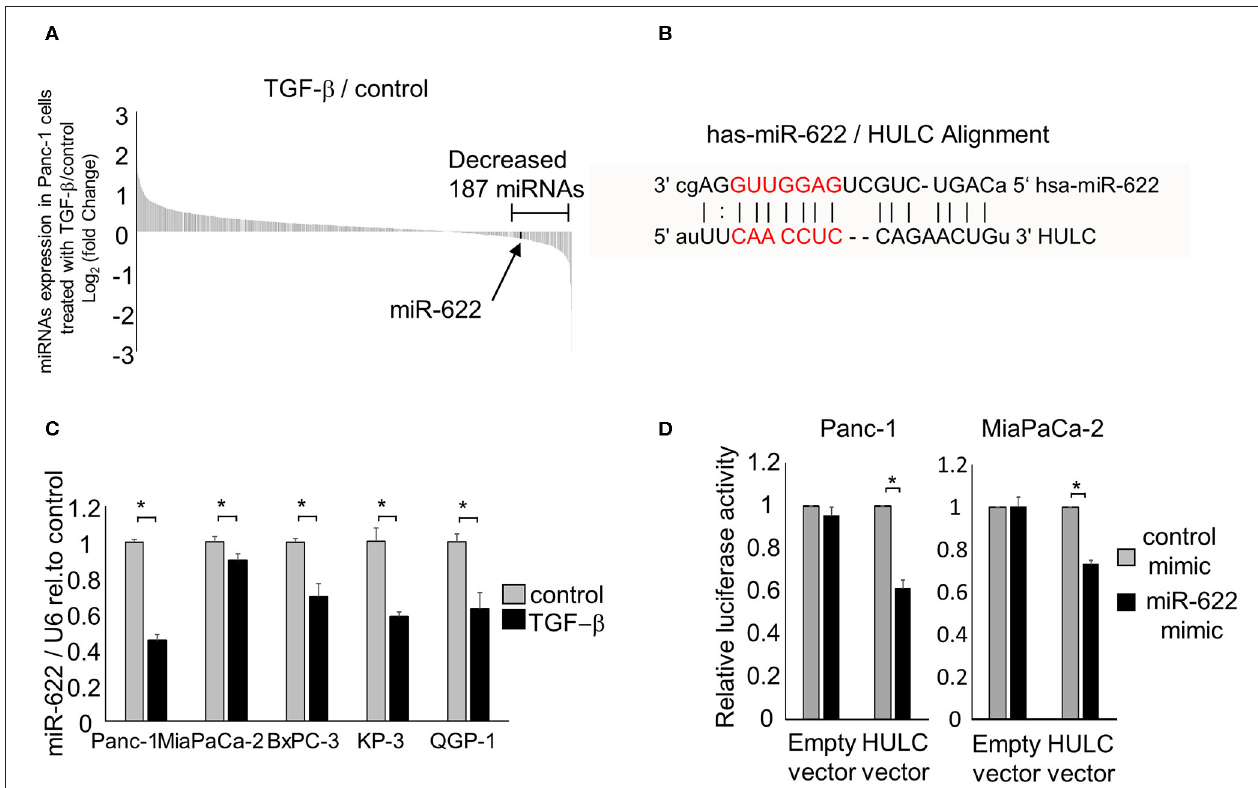
FIGURE 1 | miRNAs that can target HULC in PDAC cells. (A) Panc-1 cells were treated with or without (control) 10ng/mL of TGF- β . After incubation for 72h, RNA was isolated, and expression profiling of 2,555 miRNAs was performed. The expression of 1,719 miRNAs was detected in Panc-1 cells. Waterfall plot of all the up- and down-regulated genes in TGF- β -treated Panc-1 cells compared to those of non-treated (control) cells is shown. Expression of 187 miRNAs was decreased < 0.87-fold in Panc-1 cells treated with TGF- β . (B) miR-622 was predicted to target HULC directly by bioinformatics analysis on miRNA.org. (C) RNA was isolated and miR-622 expression was assessed by qRT-PCR in PDAC cells treated with 10ng/mL TGF- β for 72h. miR-622 expression relative to the controls is presented. Gene expression was normalized to that of U6. (D) Panc-1 and MIA PaCa-2 cells were transfected with 12.5nM miR-622 or control mimic and, after 24h, were co-transfected with 2.0 µ g of the HULC firefly luciferase reporter vector or empty vector and 0.1 µ g of the Renilla luciferase reporter pRL-SV40. Relative firefly luciferase activity was measured after a further 24h and normalized to Renilla activity. Bars are the means ± SEM of three independent experiments. * P <